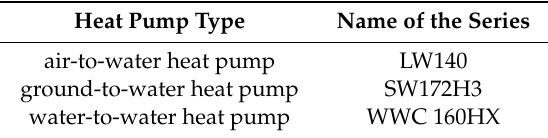
Table 1. Types of compared heat pumps manufactured by the Alpha Innotec company.